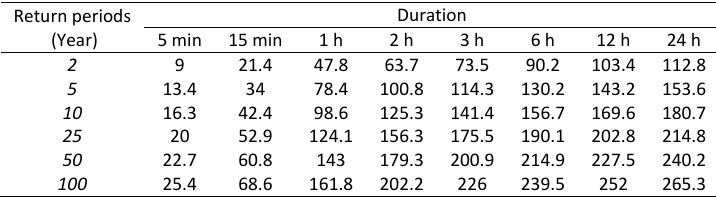
Table 2: Values of the different hypothetical rainfall events based on local RIDF data